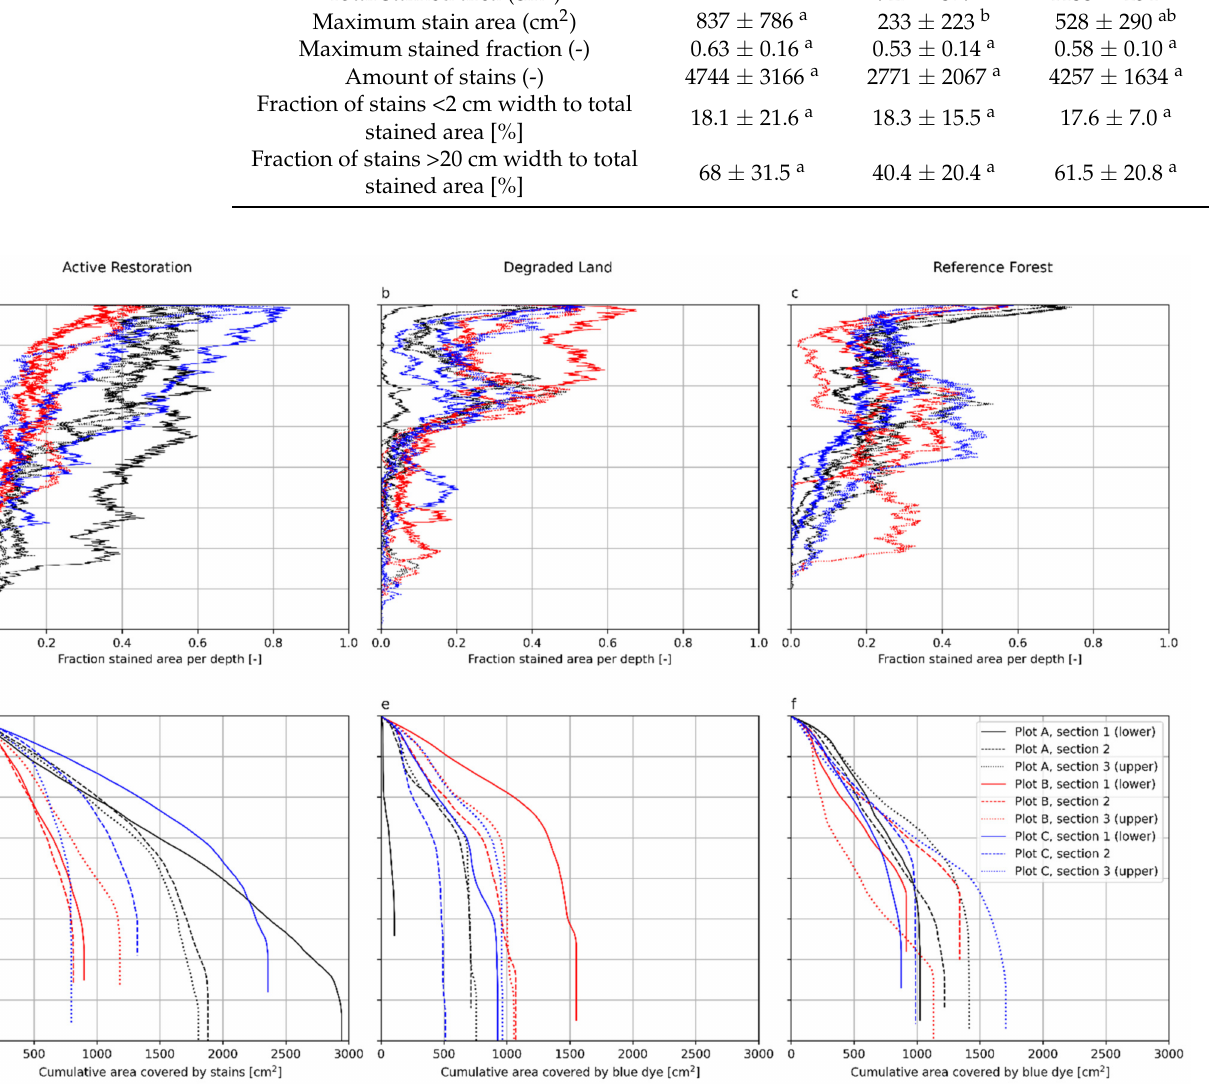
Figure 4. Results of dye tracer experiments showing the nine fractions of stained area per depth ( a – c ) and cumulative area covered by stains ( d – f ) for Active Restoration ( a , d ), Degraded Land ( b , e ), and Reference Forest ( c , f ). Lines denote sections from down- to upslope (black, grey, red, green, and blue). The continuous lines are from the first plot, dashed lines are from the second